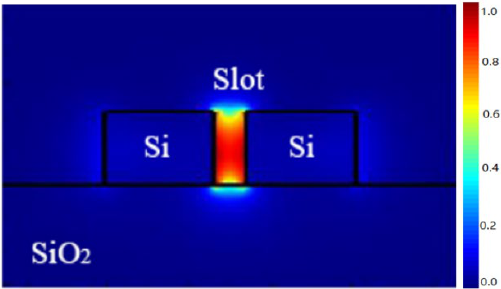
Figure 4. Mode field distribution of slot waveguide section.